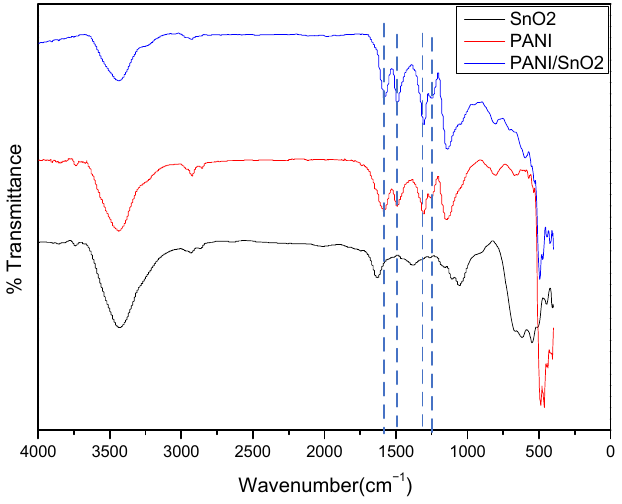
Figure 6. Fourier transform infrared (FTIR) spectra of PANI, SnO 2 , and PANI/SnO 2.